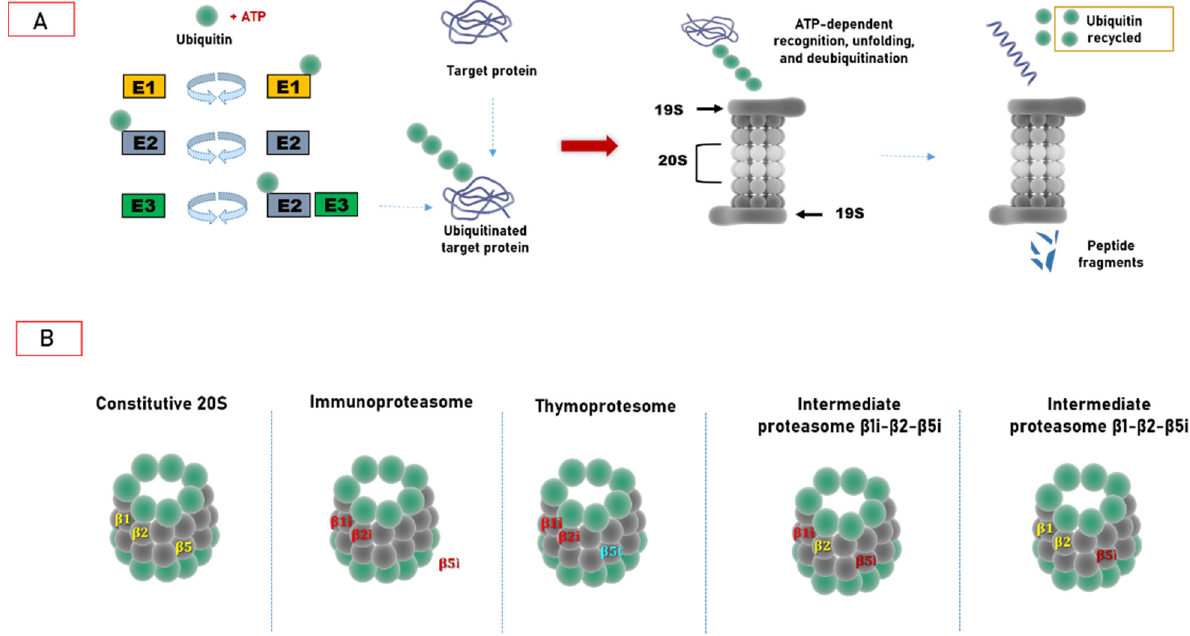
Figure 1. Ubiquitin–proteasome system. ( A ) General UPS organization. The Ub target protein conjugation cascade consists of three classes of ubiquitin ligases: E1, E2, and E3. Ub is activated by E1, forming a high-energy thioester bond; then, activated Ub is transferred to E2, and then E3 attaches Ub to a specific polypeptide substrate. At the end stage, the substrates are recognized and subjected to ATP-dependent degradation by the 26S proteasome. ( B ) Structural heterogeneity of the proteasome core particle; 20S constitutive proteasome contains the standard catalytic subunits β 1 (caspase-like activity), β 2 (trypsin-like activity), and β 5 (chymotrypsin-like activity). The immunoproteasome incorporates the inducible catalytic subunits β 1i, β 2i, and β 5i, which have different catalytic specificities. The thymoproteasome is expressed only by cortical thymic epithelial cells and is characterized by the presence of β 1i- β 2i, and β 5t subunits. Finally, intermediate proteasomes contain a mix of constitutive and inducible subunits: β 1i,- β 2- β 5i and β 1- β 2, and β 5i, respectively.